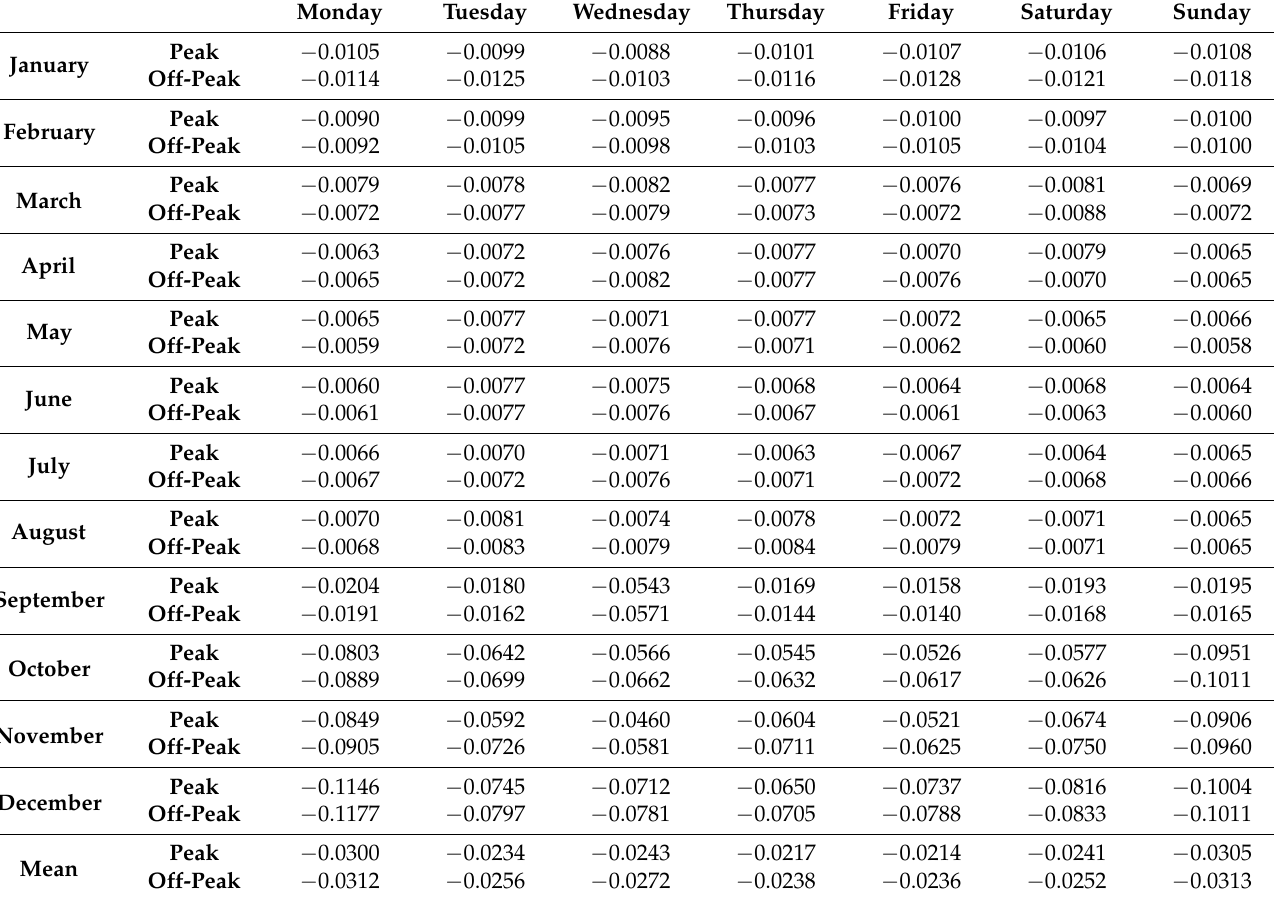
Table A2. Summary Statistics of the Elasticity Estimates Aggregated by Day of the Week-Peak and Off-Peak